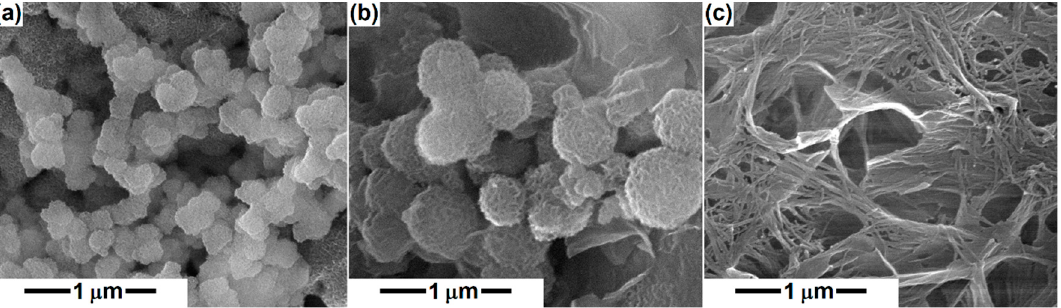
Figure 5. SEM images of the mineral powders after immersion in simulated body fluid for 4 weeks: ( a ) diopside, ( b ) akermanite, and ( c ) merwinite compositions. ( a ) diopside, ( b ) akermanite, and ( c ) merwinite compositions.